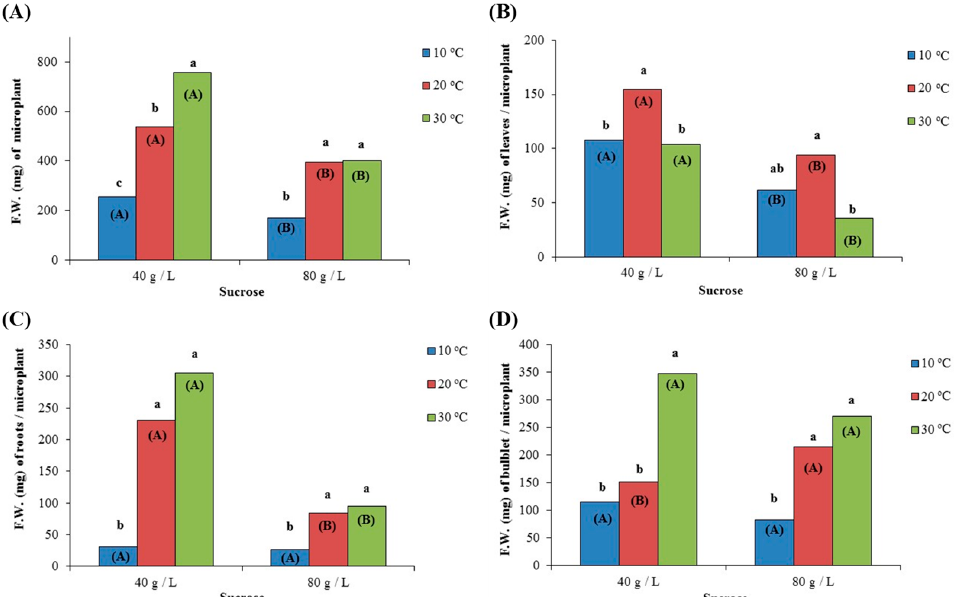
Figure 5. Effect of two different concentrations of sucrose (40 g/L and 80 g/L) at three different temperatures (10 °C, 20 °C, and 30 °C) on the fresh weight (F.W. expressed mg) of ( A ) microplant; ( B ) leaves per microplant; ( C ) roots per microplant; and ( D ) bulblet per microplant, after growing for 72 days in culture medium. In each sucrose concentration, the same lowercase letters indicate non-statistically significant differences among the temperature treatments, according to the LSD test ( p ≤ 0.05). In each temperature, the same uppercase letters in parenthesis indicate no statistically significant differences between sucrose concentrations, according to Student’s t -test ( p ≤ 0.05).